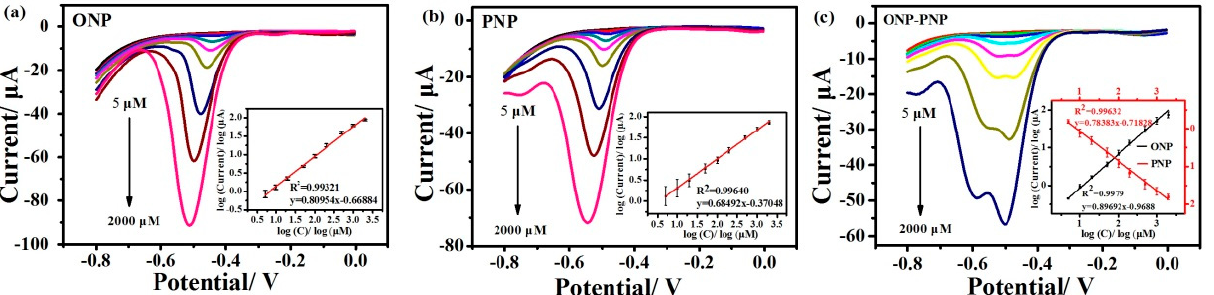
Figure 7. DPV of Pd 2+ /COFs/GCE with individual addition of ( a ) ONP and ( b ) PNP (5, 10, 20, 50, 100, 200, 500, 1000, and 2000 µM) into 0.1 M PBS (pH = 7.0), respectively. Inset: Linear relationship between logarithm of peak current and logarithm of concentrations of ( a ) ONP and ( b ) PNP. DPV of Pd 2+ /COFs/GCE with simultaneous addition of the same concentration of ( c ) ONP and PNP (5–2000 µM) into 0.1 M PBS (pH = 7.0). Inset: Linear relationship between logarithm of peak current and logarithm of concentrations of ( c ) ONP and PNP.